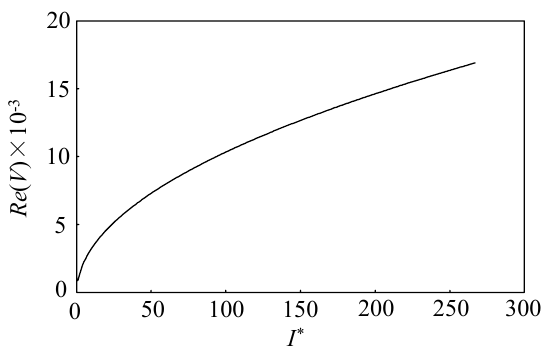
Fig. 3 Relation between inertia-moment ratio I * and Reynolds number Re ( V ) based on a theoretical descent velocity V at depth-to-width ratio λ = 0.3, C = 3.86 × 10 2